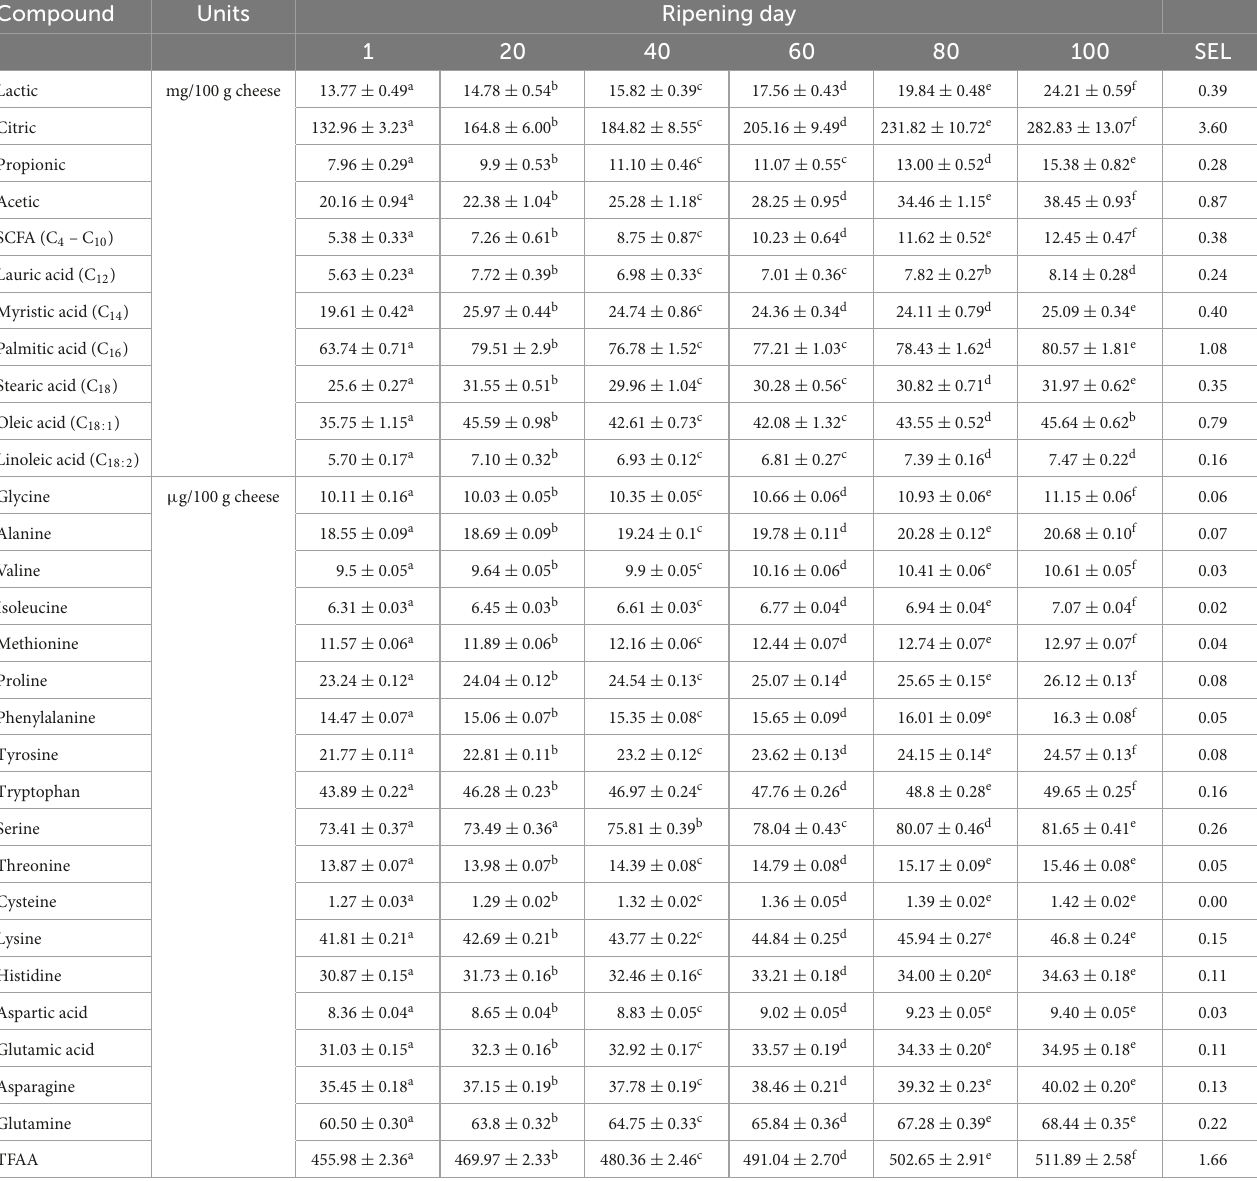
TABLE 1 Changes in certain organic acids, free fatty acids, and free amino acids in white cheese during the ripening period (Mean ± SD).